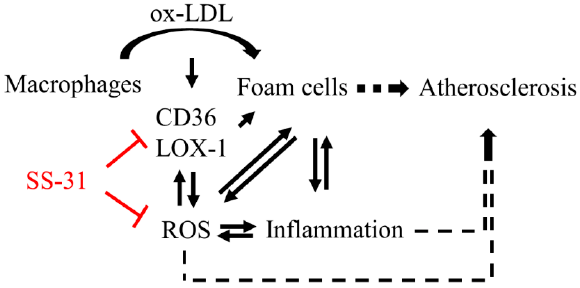
Figure 5. Schematic diagram for suppression of ox-LDL-elicited foam cell formation by SS-31. Ox-LDL stimulates its own uptake by induction of macrophages surface receptor CD36 and LOX-1 expression, resulting in the increased influx of ox-LDL to promote macrophages converting into foam cells. Foam cell formation triggers generation of ROS, which interplays with inflammation. SS-31 reduces production of ROS and prevents the upregulation of CD36 and LOX-1, consequently decreases foam cell formation.